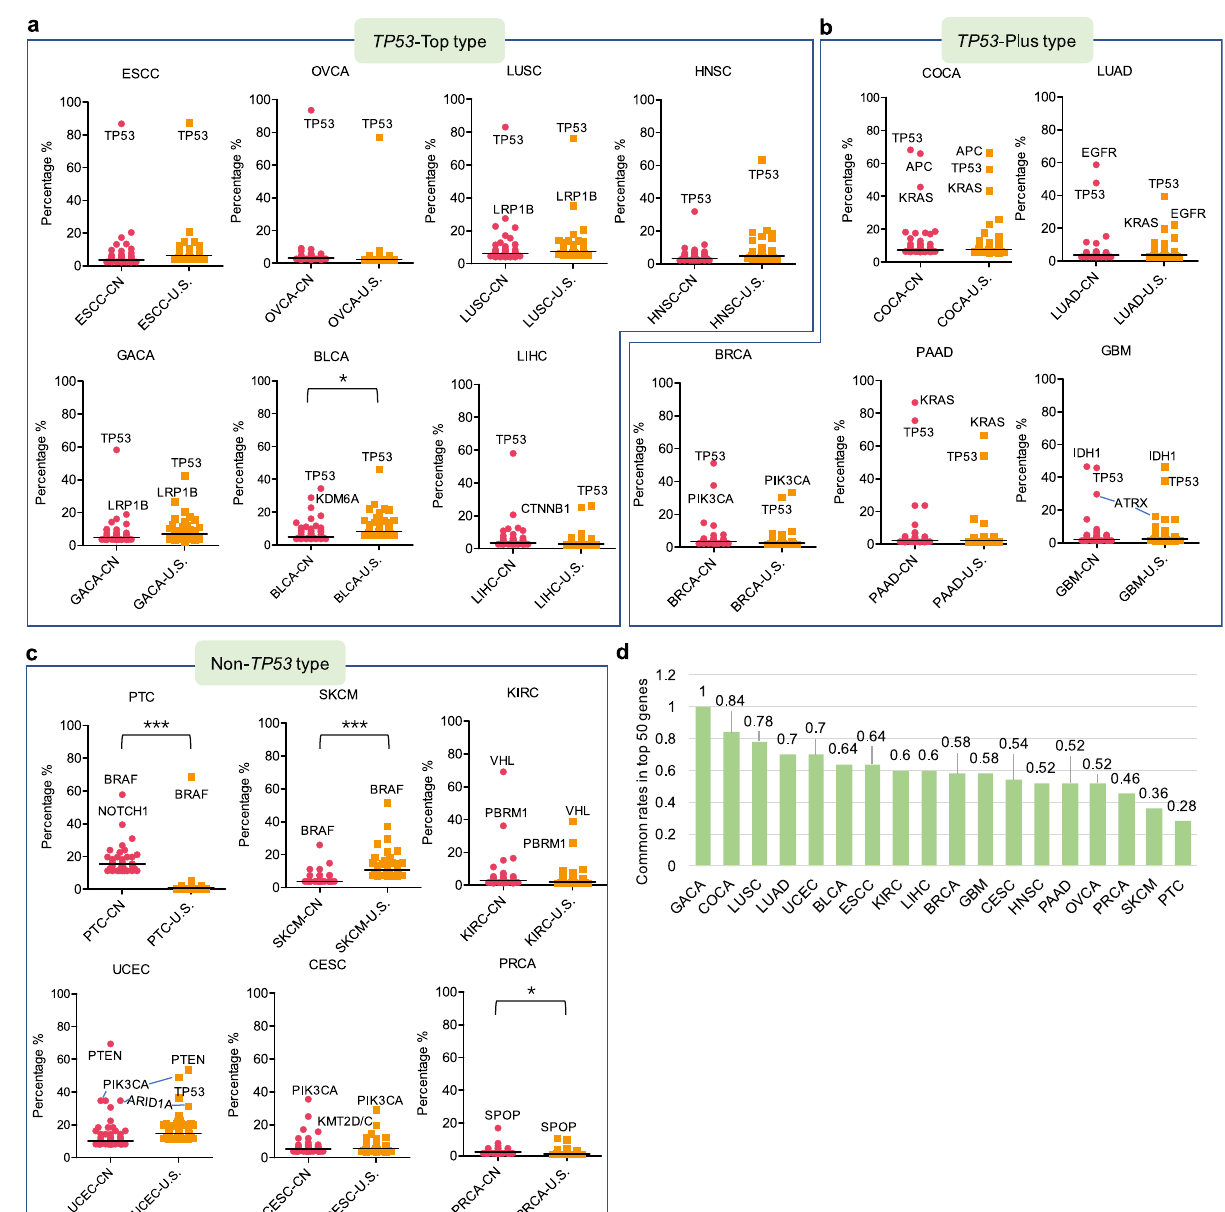
Fig. 4 | The classi fi cation of 18 common cancer types into three patterns. a – c The comparison of the mutationratesoftop 50 cancer genes ineach of the 18 most common solid tumor types from China and U.S. cohorts. The 18 cancers are classi fi edintothreetypes: TP53 -Toptype, TP53 -Plustype,andNon- TP53 type,based on the rank of TP53 with respect to other top mutated genes. The differences between China and U.S. cohorts were statistically evaluated using the unpaired t